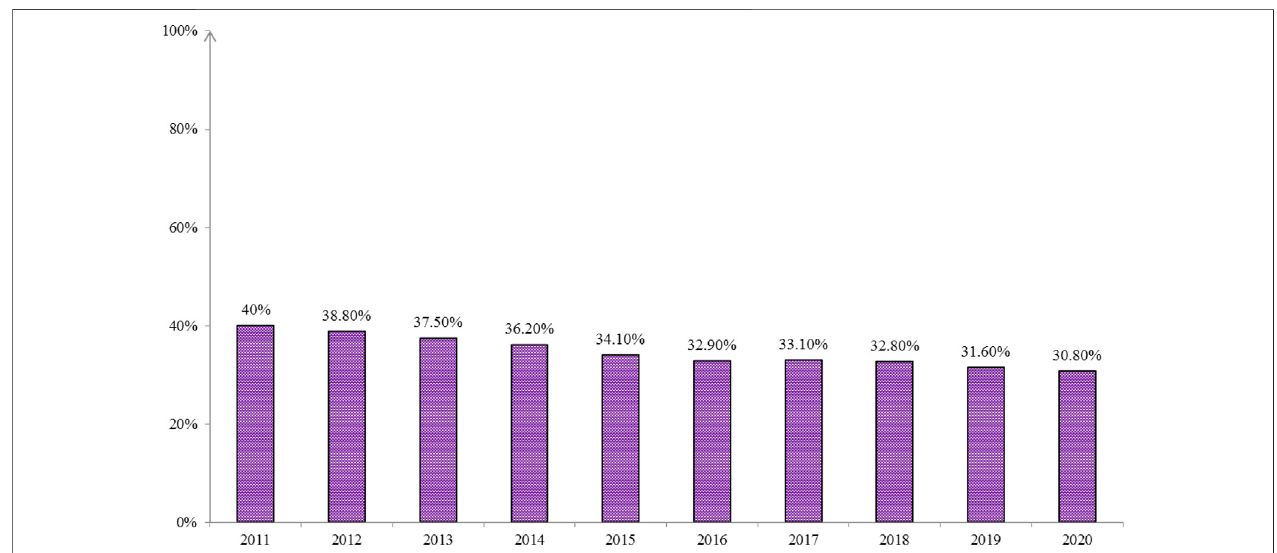
FIGURE 10 | Percentage of industry sector on GDP in China during 2011 – 2020.Source: The author searched the information from GDP Composition in the China Statistical Yearbook 2021.